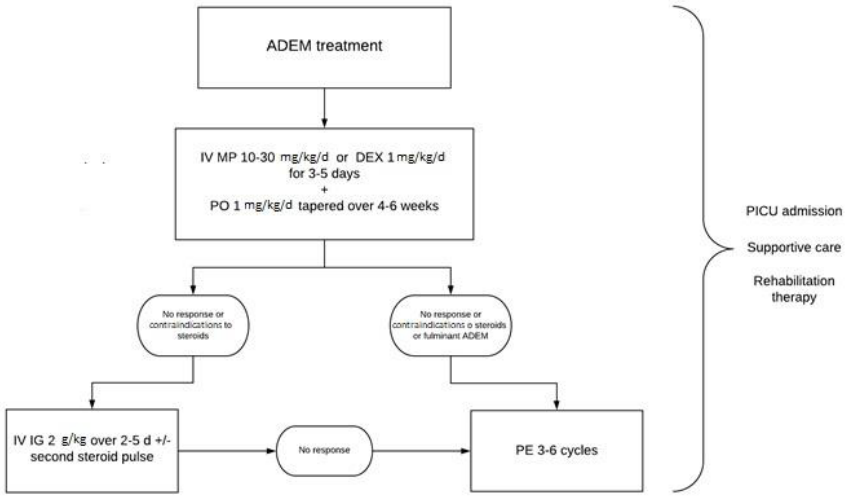
Figure 3. Therapeutic algorithm in pediatric acute disseminated encephalomyelitis (ADEM).